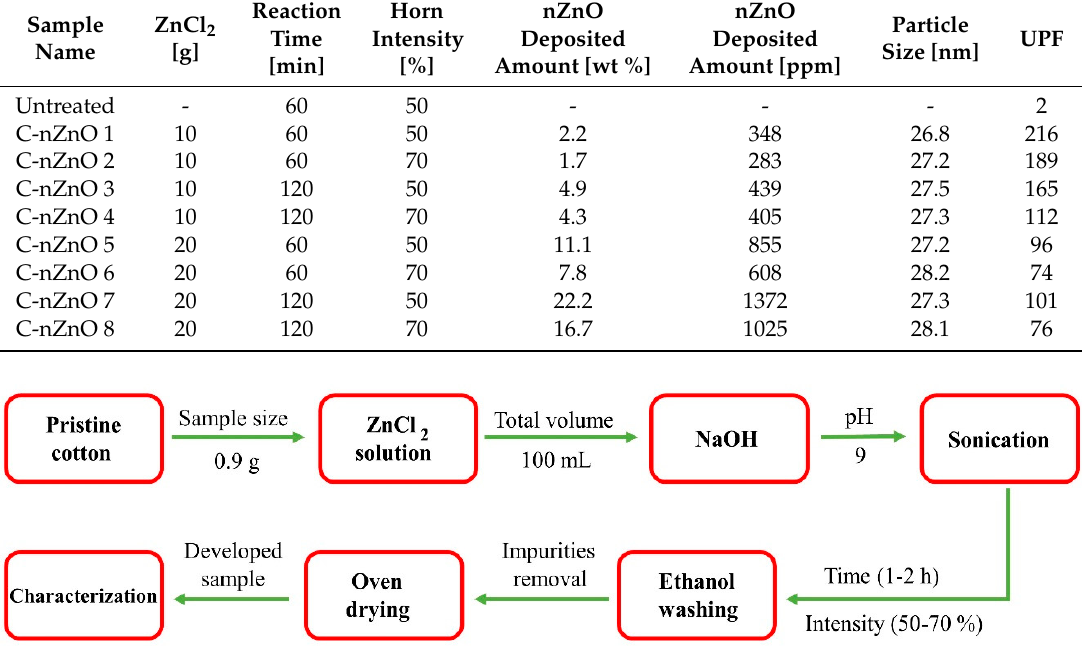
Figure 1. The proposed mechanism for the development of C-nZnO composites.